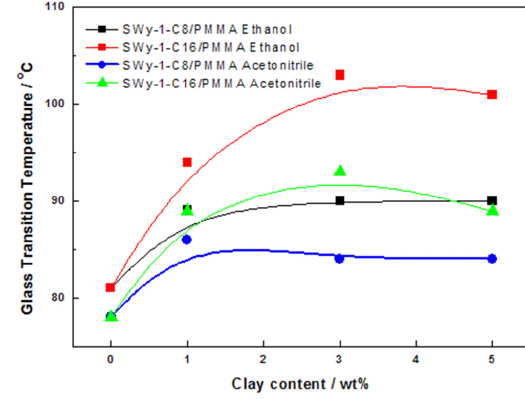
Figure 4. Glass transition temperature of nanocomposites as a function of clay